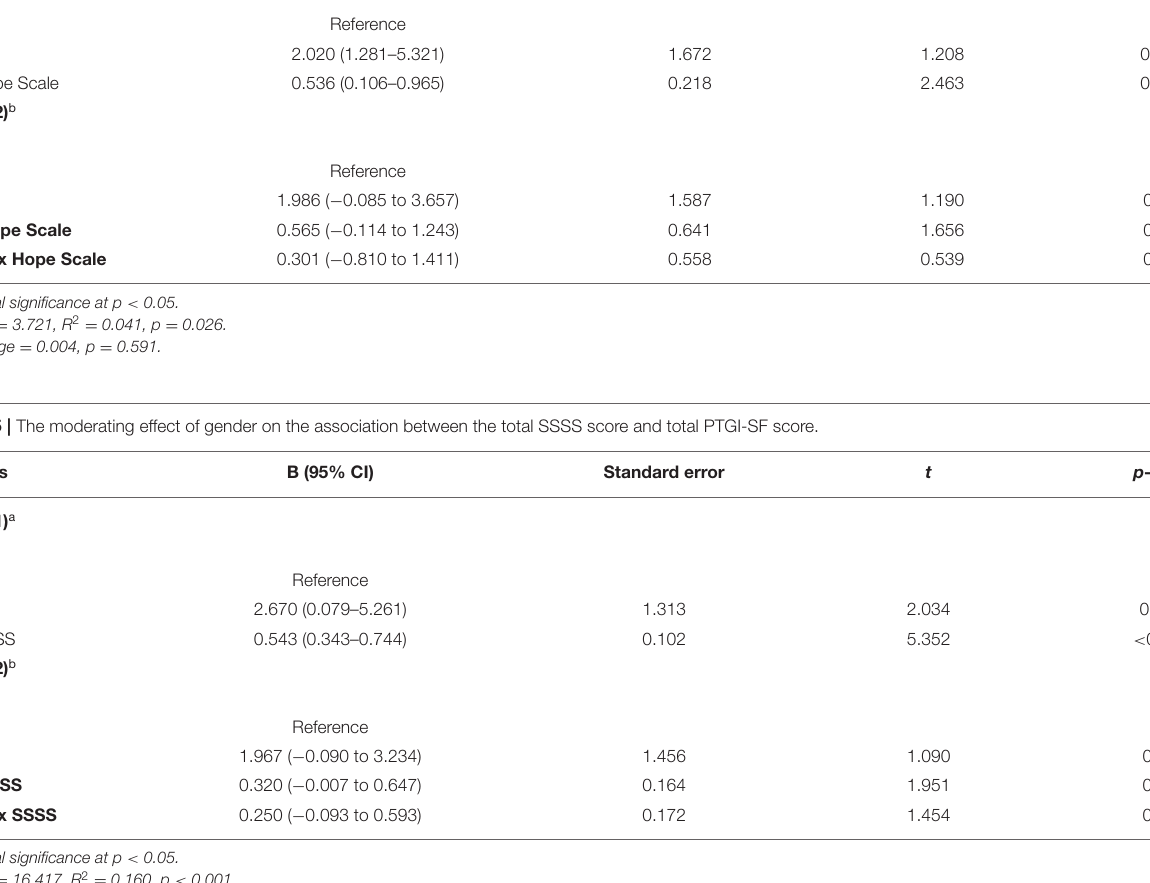
TABLE 4 | The moderating effect of gender on the association between the total Hope Scale score and total PTGI-SF score. Variables